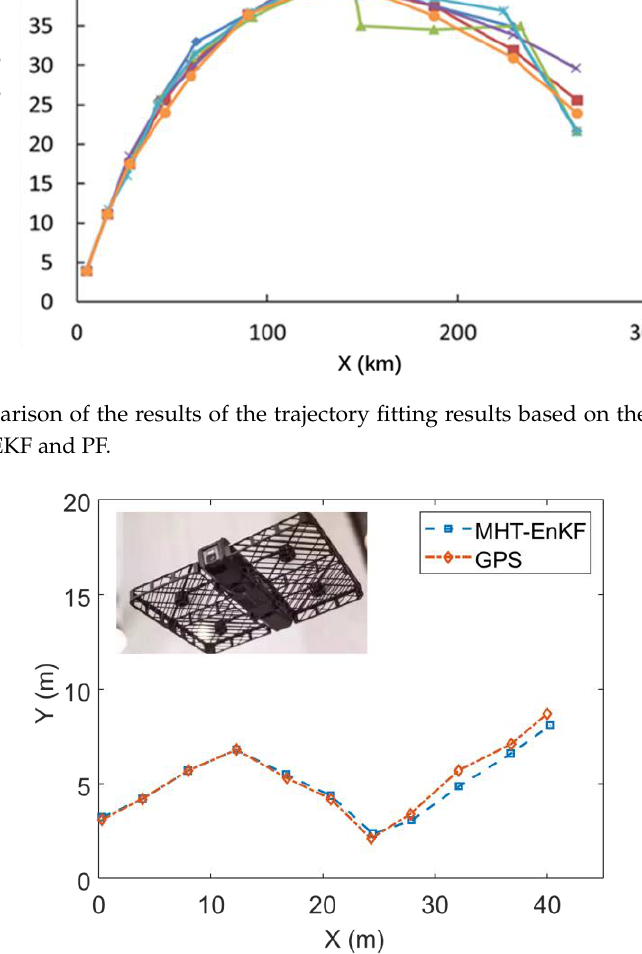
Figure 10. The MHT-EnKF tracking results for the tracking of a drone.